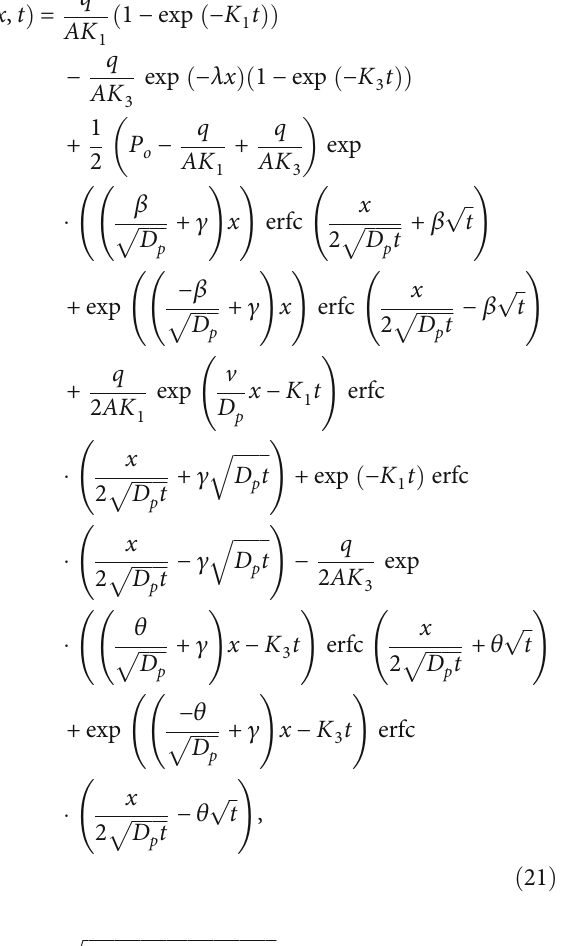
and P of various values of the rate of pollutant addition ( q ) at t = 1 day and 0 : 06 ≤ q ≤ 0 : 48 1 2